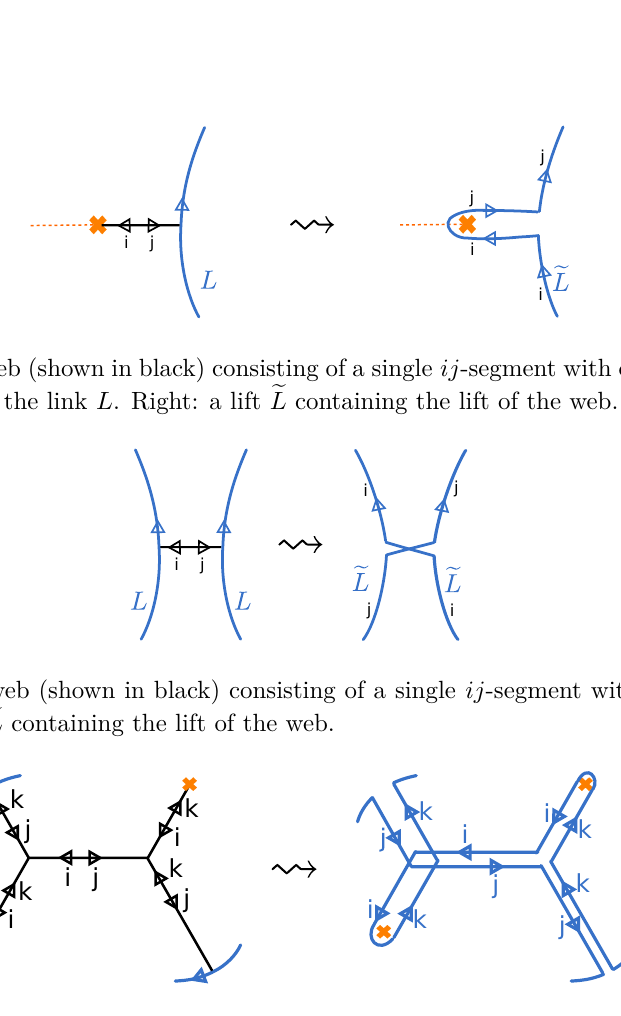
Figure 15 . Left: a more elaborate web, with two endpoints on branch points and two on the link L . Right: a portion of a lift e L of L containing the lifted